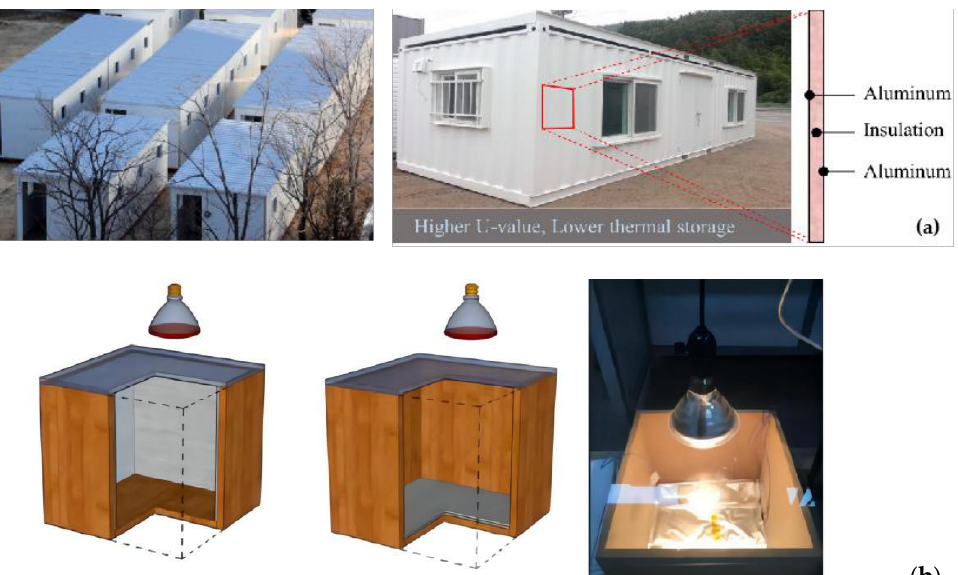
Figure 1. ( a ) Temporary hospital units in Seoul Medical Centre, Korea. ( b ) Schematic diagrams of box experiments on the thermal properties of PCMs. Reprinted with permission from Ref. [6] © 2021, Elsevier Ltd.